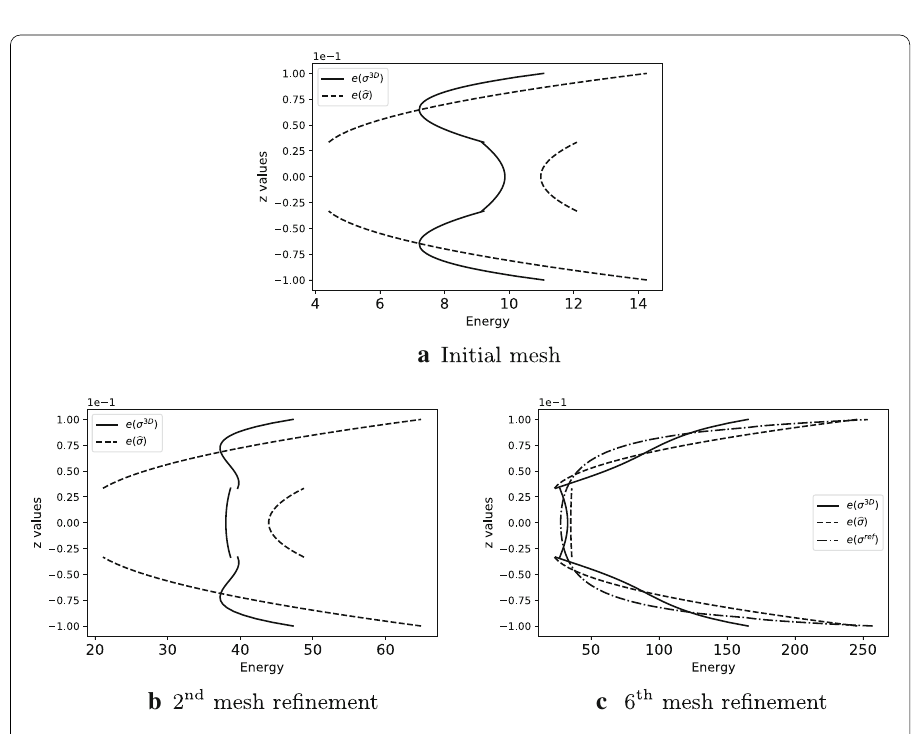
Fig. 3 Energy densities across the plate thickness computed for σ 3 D and (cid:13) σ at the plate edge for n =